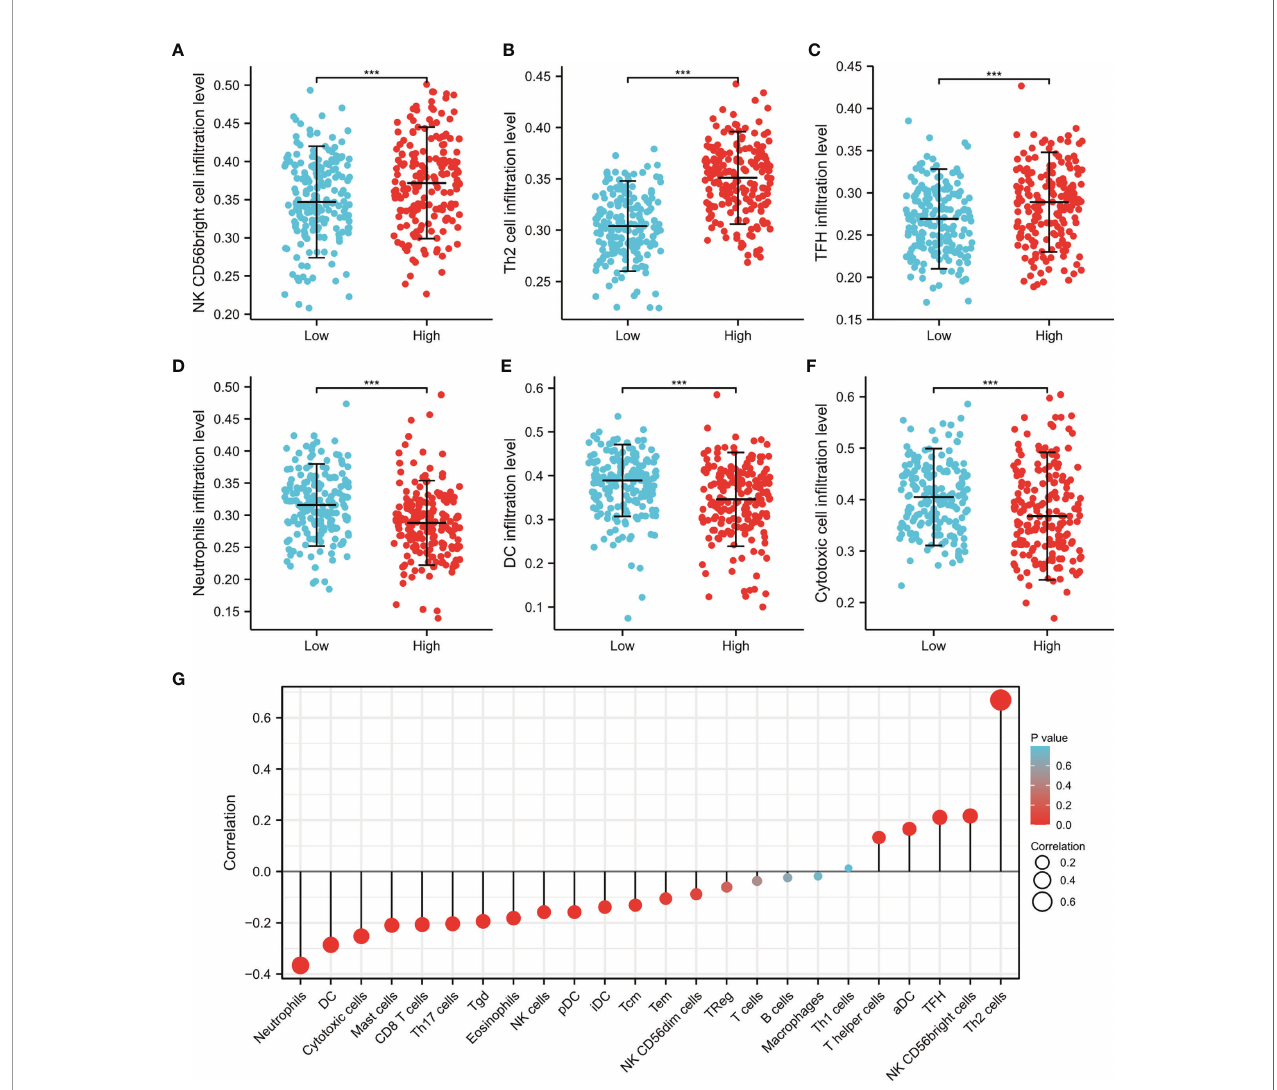
FIGURE 10 | The CDT1 expression and immune cell in fi ltration using the TIMER database. (A – F) Different proportions of immune cell subtypes in HCC samples in CDT1 high and CDT1 low groups. (G) The correlation between CDT1 expression and 24 immune in fi ltrating cells. *** p <